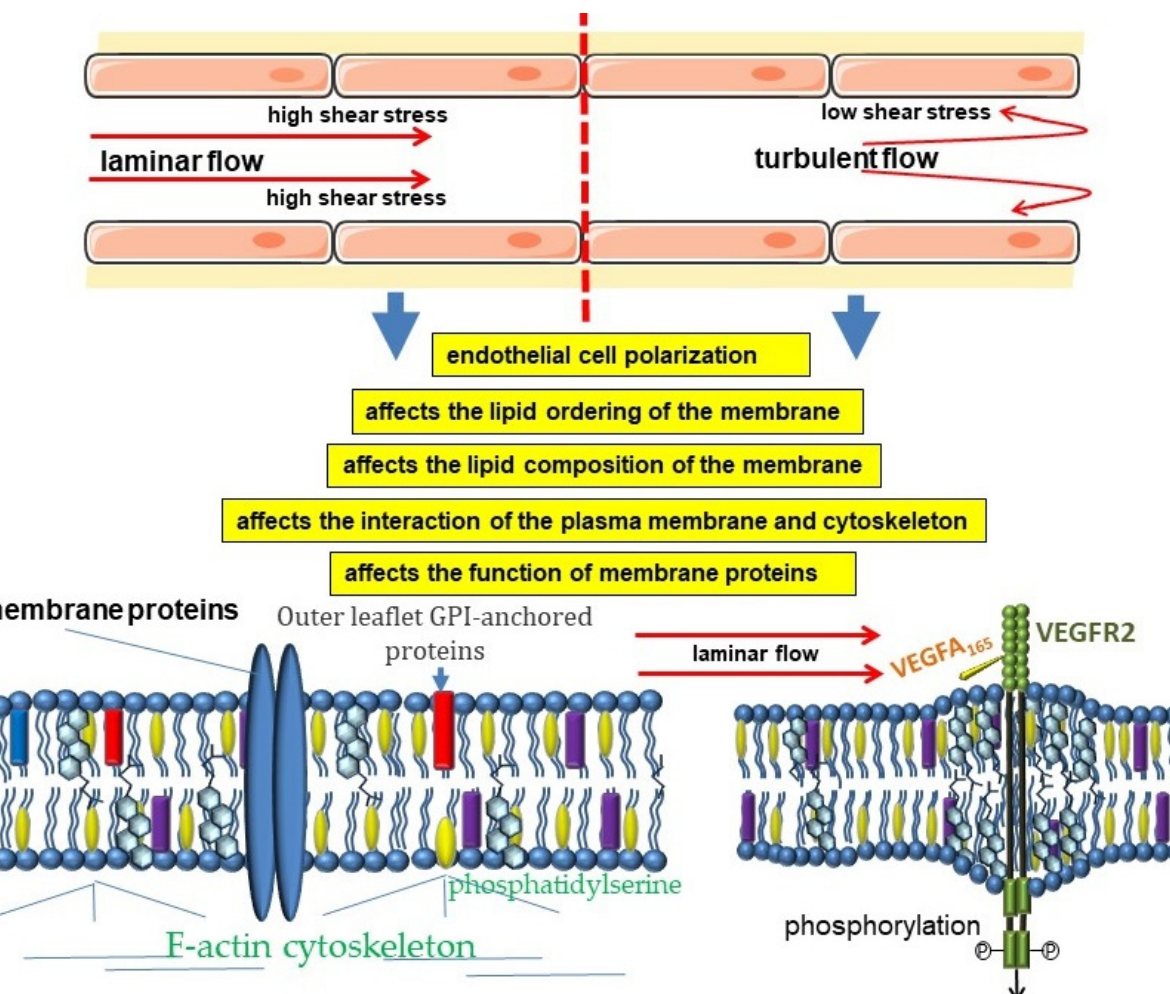
Figure 1. Cross-links of hemodynamic forces and biophysical properties of the plasma membrane of endothelial cells.